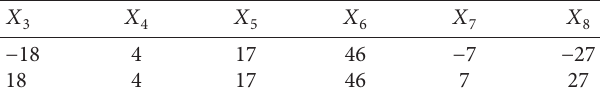
Table 4: Model-free checks with edge plan in Table